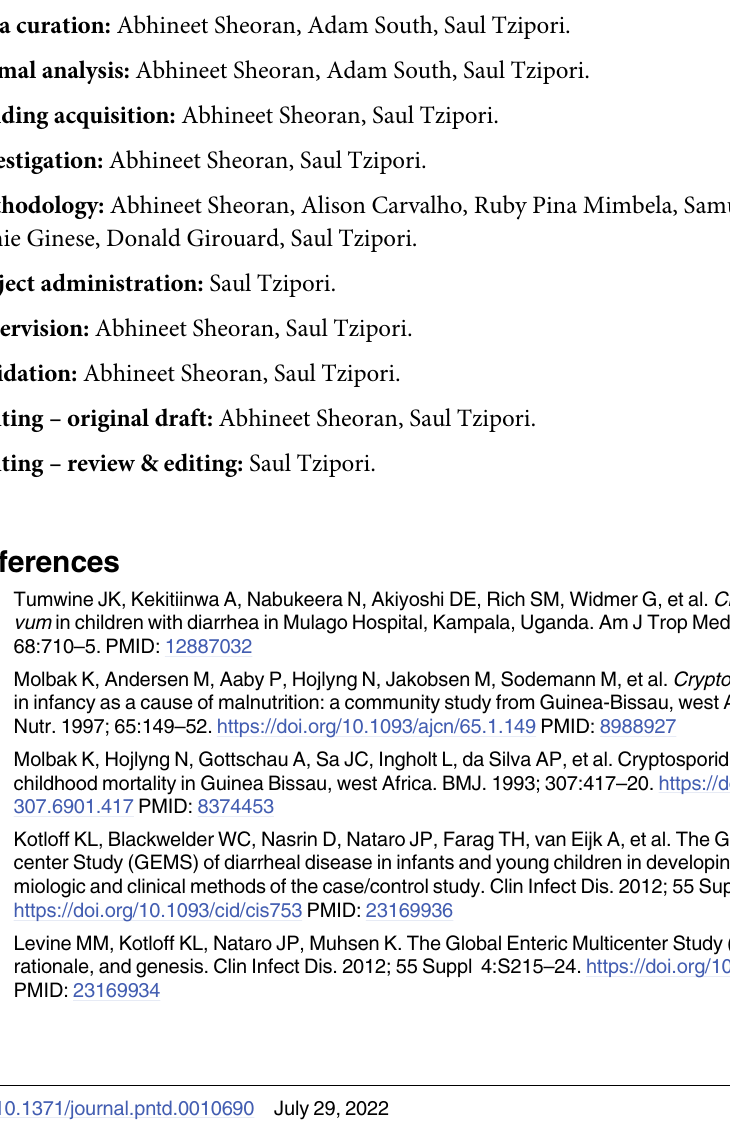
S3 Table. Daily Cryptosporidium hominis oocyst excretion pattern following infection of the piglets of control sow #7 with C. parvum, and serum antibody titers on day of the infec- tion (first bleed) and at euthanasia (second bleed). S4 Table. Daily Cryptosporidium hominis oocyst excretion pattern following infection of the piglets of sow #6 immunized with C. parvum, and serum antibody titers on day of the infection (first bleed) and at euthanasia (second